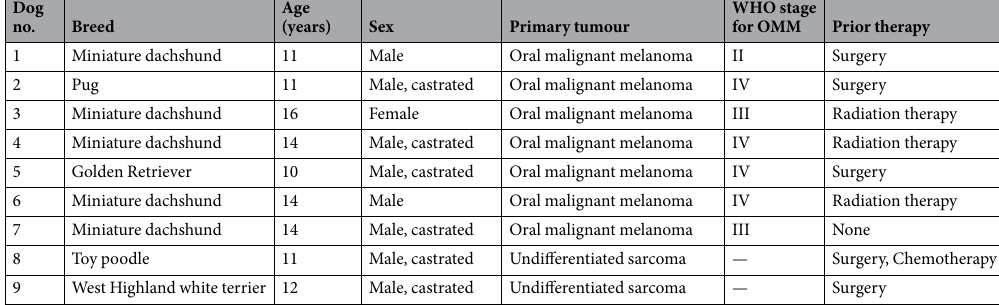
Table 2. Characteristics of dogs treated with c4G12 in the pilot study. Prior therapy included definitive/ palliative surgery, definitive/palliative radiation therapy and chemotherapy with chlorambucil.